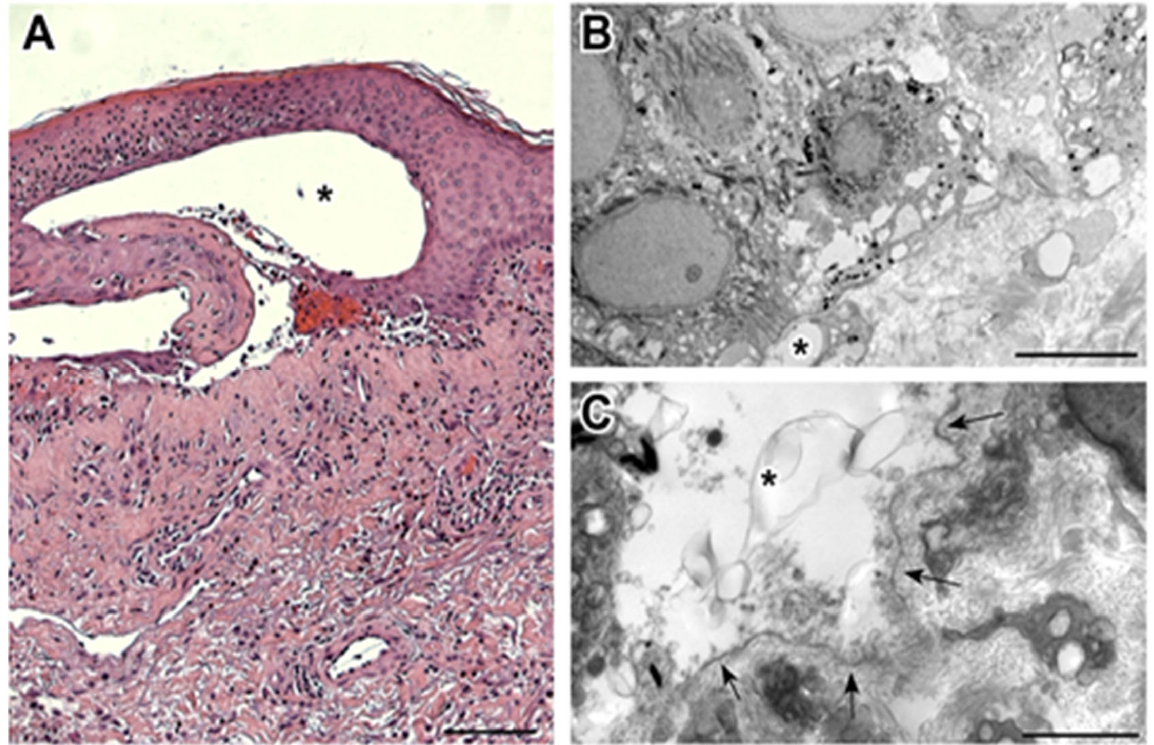
Figure 2. ( A ) The bullous lesion at histopathologic examination is composed of a subepidermal blister (*), with underlying sclerosis of the papillary component of the dermis, dilated capillary vessels, and perivascular chronic lymphocytic infiltrate with an eosinophilic component. A significant actinic elastosis is visible in the reticular dermis. (Hematoxylin/eosin staining; 100× magnification; bar 100 μ m). ( B ) Transmission electron microscopy performed on the perilesional skin reveals the presence of small subepidermal blisters (*) without epidermal basal cell damage (uranyl acetate/lead citrate; bar: 5 μ m). ( C ) Ultrastructural analysis of lesional skin shows the formation of a blister (*) between the basal keratinocytes and the partially fragmented lamina densa (arrows), which defines the floor of the blister (uranyl acetate / lead citrate; bar: 2 μ m).